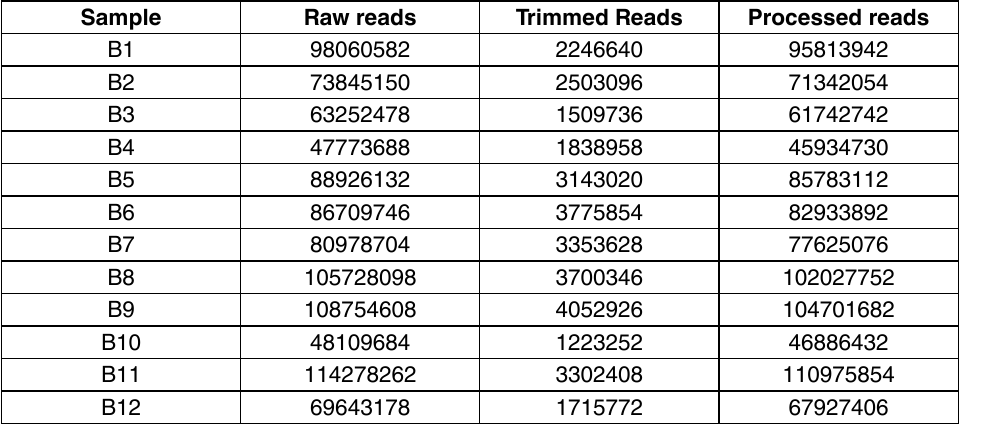
table 1 . Summary of raw, trimmed and processed reads across RNA sequencing data of milk somatic cells of